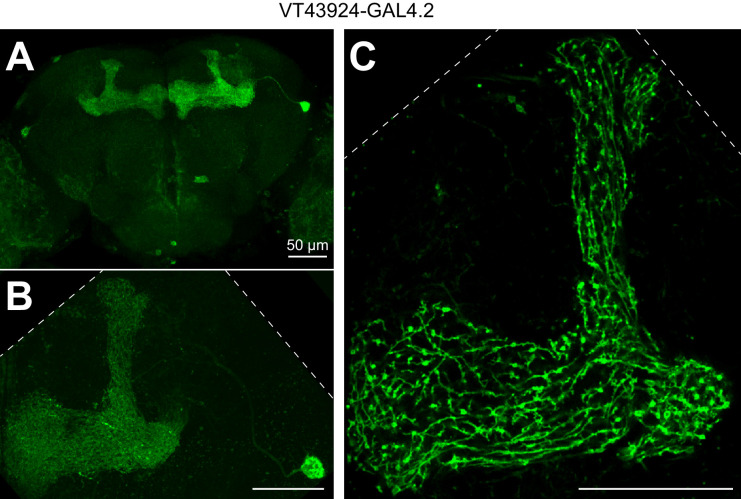
Expression pattern of VT43924-GAL4.2.(A) Maximum intensity projection of confocal image of VT43924-GAL4.2-SV40 > UAS-CD8::GFP. (B) As in A, but zoomed in on a single APL (unfixed brain imaged on two-photon; calyx is less visible compared to A because the tissue is not fixed and cleared). (C) Same brain as B, single optical plane zoomed in to show fine structure of APL in the lobes. Scale bars, 50 µm. Dashed lines show the edge of the field of view.